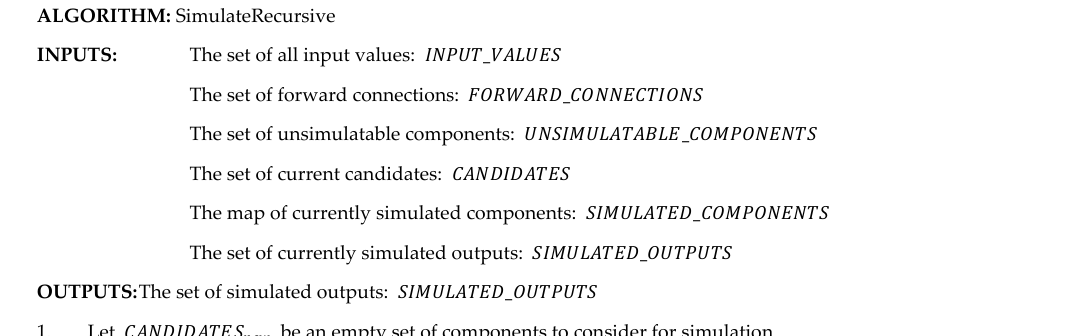
Algorithm 2. Pseudo code of the SimulateRecursive-function of the simulator, used to perform the simulation of model components in a recursive fashion.